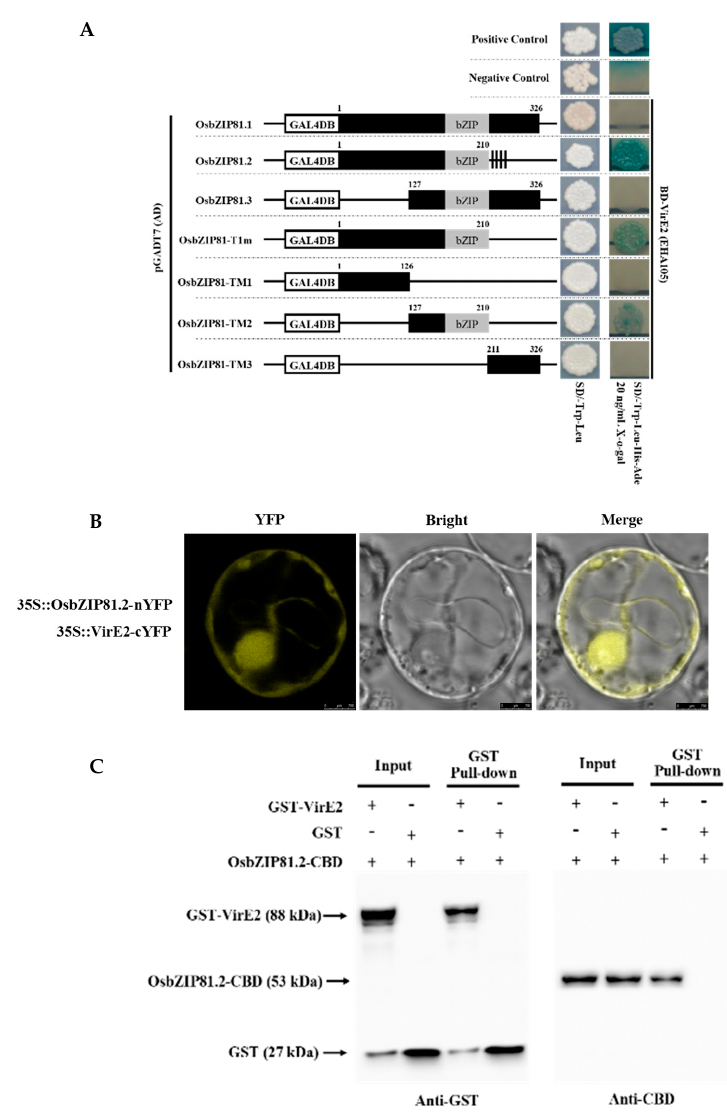
Figure 7. OsbZIP81.2 can interact with virulence effector protein 2 (VirE2). ( A ) Different truncated proteins of OsbZIP81 and VirE2 in yeast two-hybrid assay. ( B ) OsbZIP81.2 interacts with VirE2 in a BiFC assay. ( C ) OsbZIP81.2 interacts with VirE2 in a GST pull-down assay.